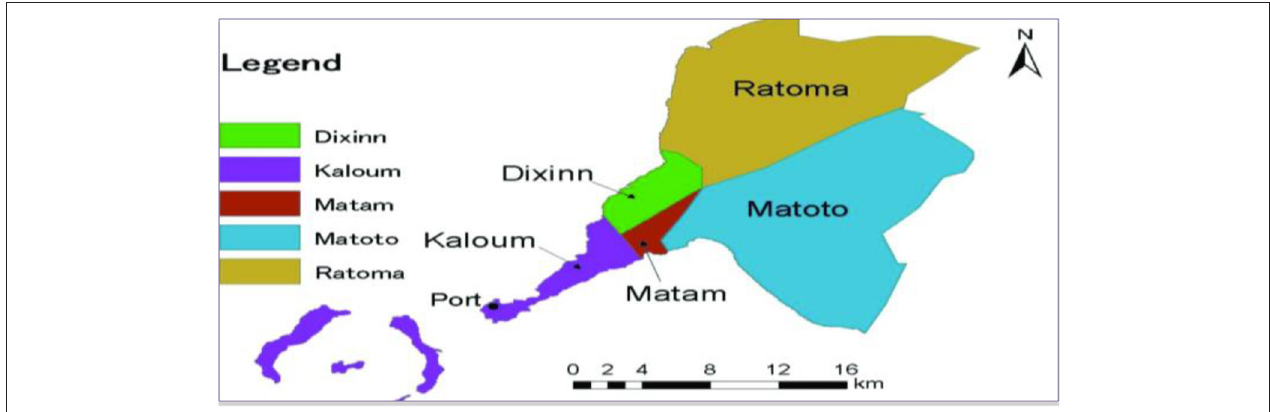
FIGURE 1 | Conakry with its 5 communes according to the national direction of the territory (13).